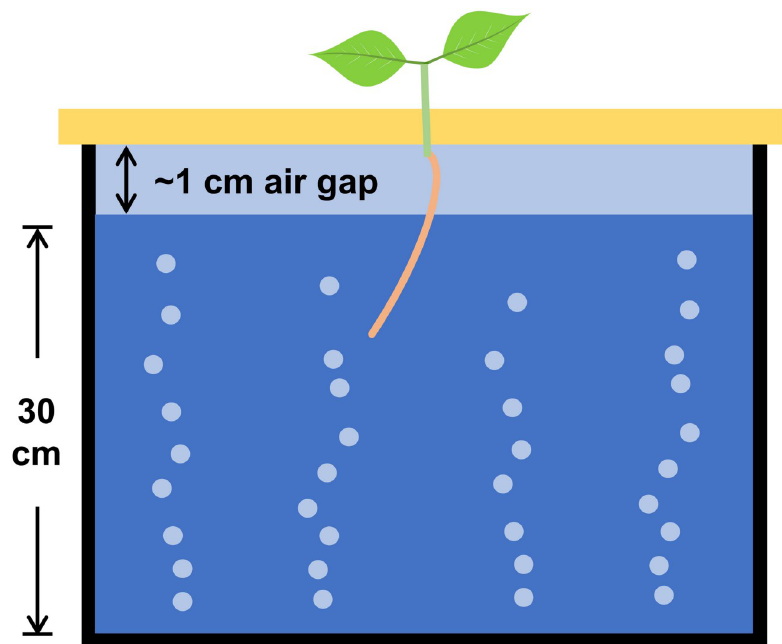
Fig 1. Side-view diagram of seedling transplanted into a hydroponic tank. The root must be long enough to span the 1 cm air gap and have ample access to the solution immediately after